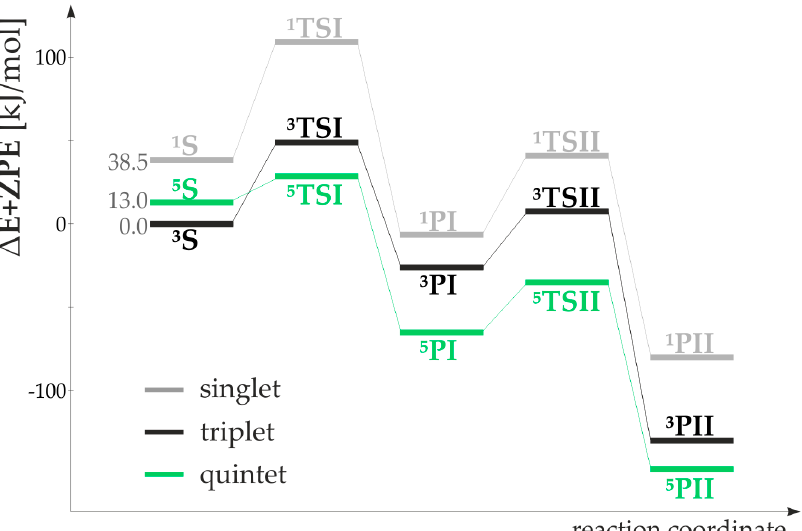
Figure 5. Relative energies with ZPE correction (Table S5) of singlet ( 1 , gray ), triplet ( 3 , black ), and quintet ( 5 , green ) for the reaction of cyclohexene oxidation catalyzed by [(salen)Fe IV =O] to alcohol. For the initial complexes S (in three various spin states) the values of starting relative energies are given next to the respective line. The legend of used symbols: S—substrates: [(salen)Fe=O)]+H-C 6 H 9